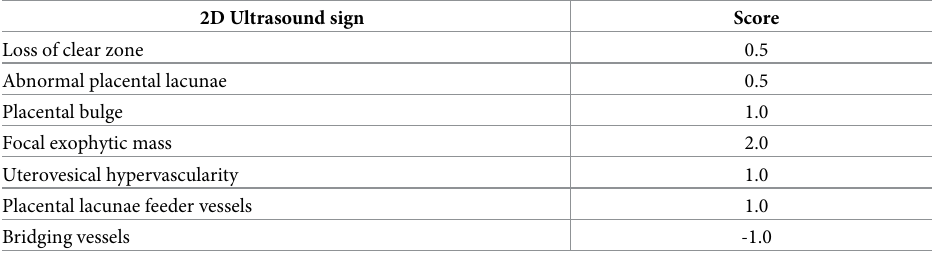
Table 5. Scores for each ultrasound sign to predict massive PBL in the PAS